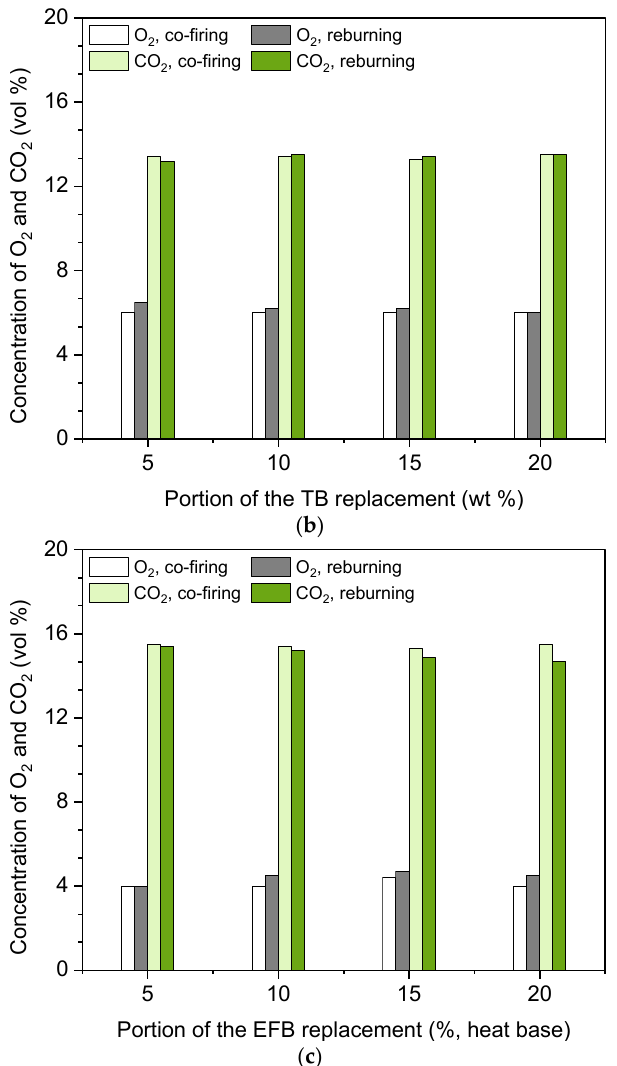
Figure 3. O 2 and CO 2 concentrations at furnace exit for various WP cofiring and reburning ratios: ( a ) wood pellet (WP), ( b ) torrefied biomass (TB), and ( c ) empty fruit bunch (EFB).